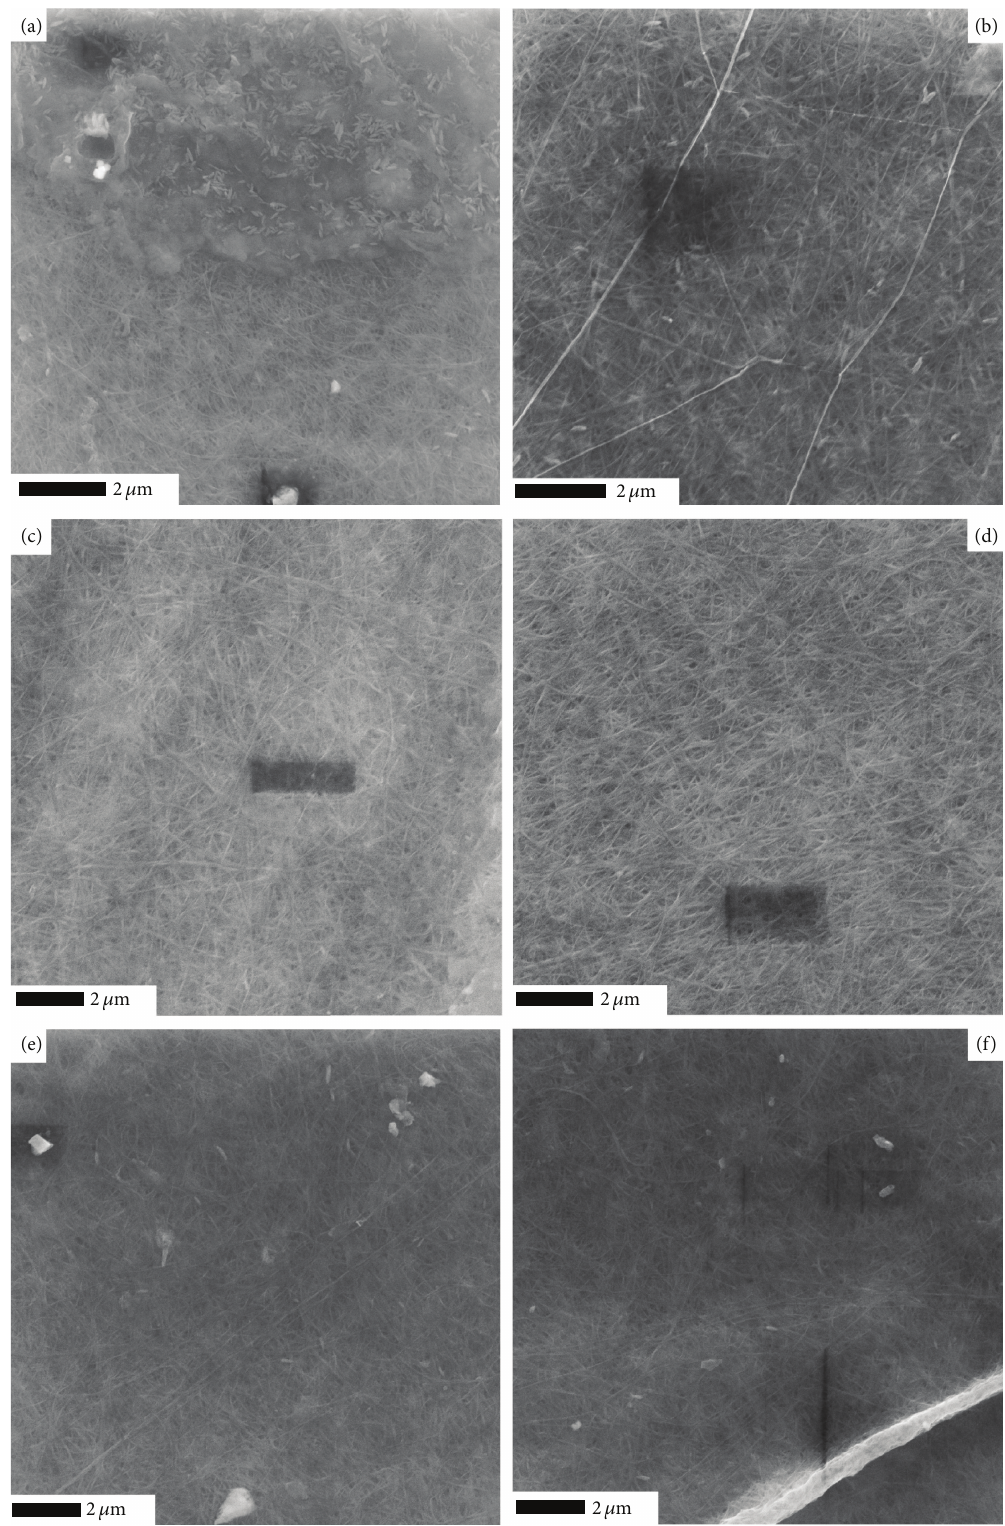
Figure 6: Scanning electron microscopy images of control (a, c, e) and RMF exposed (b, d, f) BC obtained after 3, 5, and 7 days of cultivation,